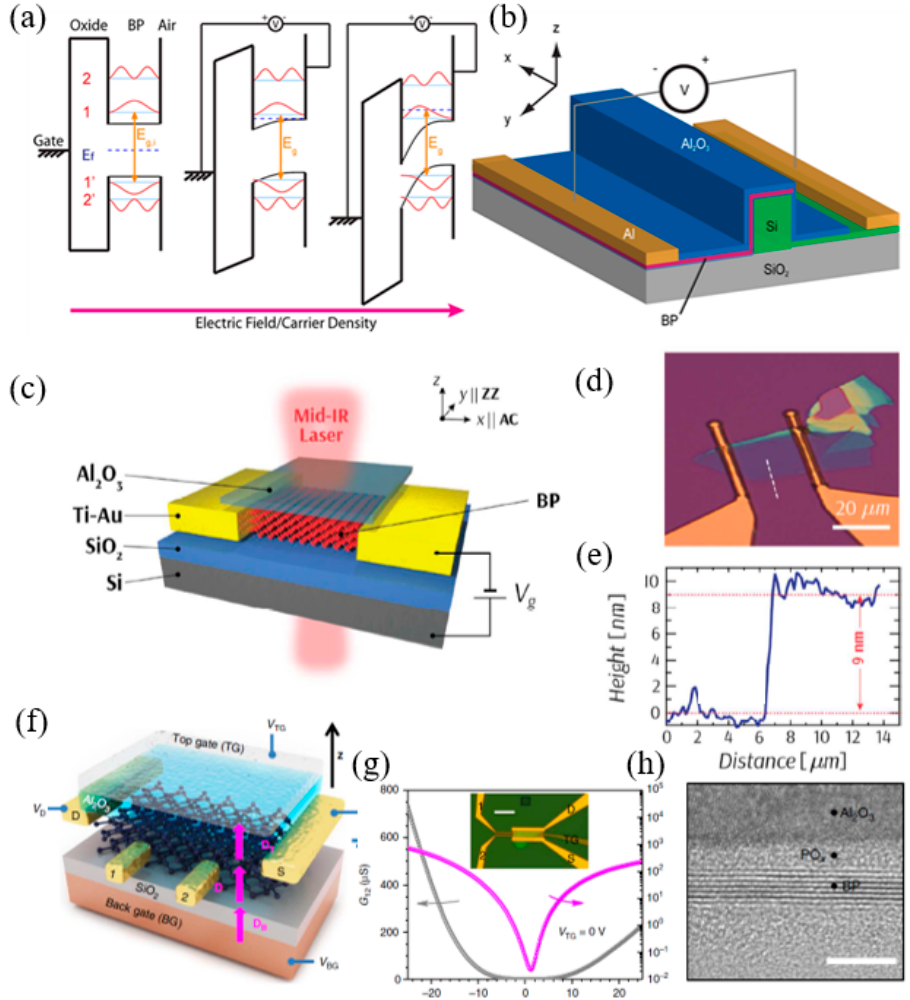
Figure 13. ( a ) Schematic diagram, band diagram, and wave function of 5 nm thick BP QW. ( b ) Modulator schematic [276]. ( c ) Schematic diagram of multilayer BP modulator. ( d ) Optical microscope image of BP modulator. ( e ) Atomic force microscope image of BP modulator [277]. Copyright 2017 American Chemical Society. ( f ) Test program for BP band gap tuning. ( g ) 4 nm thick BP film conductance as a function of top gate zero bias voltage and back gate bias voltage. ( h ) BP under an atomic microscope [278]. Copyright 2017 Nature Publishing Group.